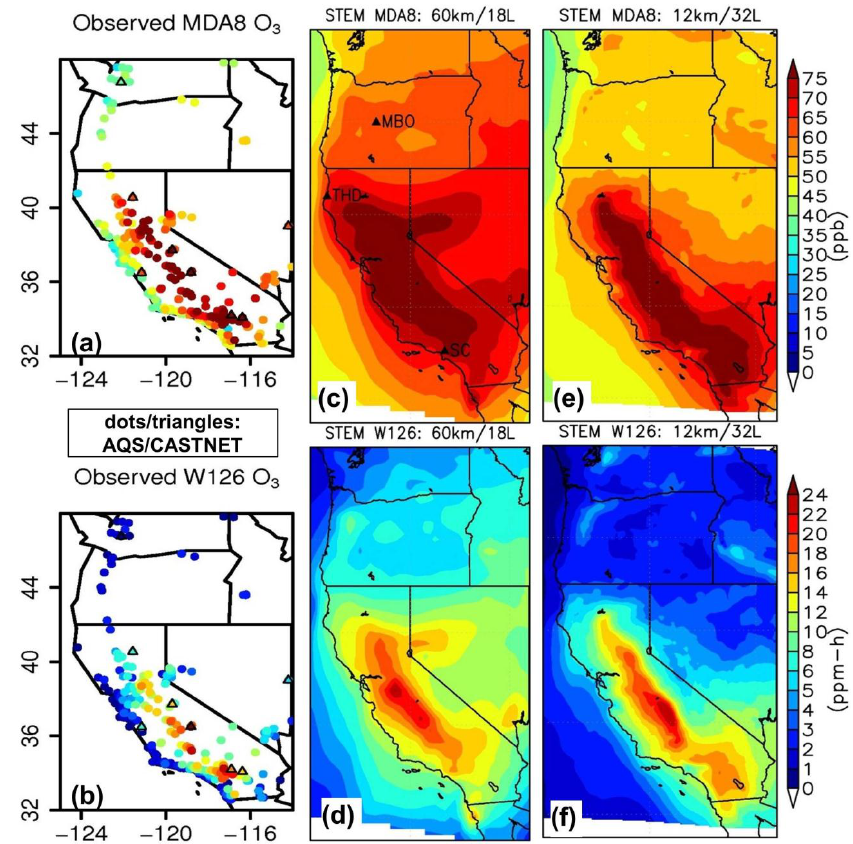
Fig. 2. Comparison of observed and modeled MDA8 and W126 monthly index (MI). See text in Sect. 3.1.1 for definition of MDA8 and W126 MI indexes. (a–b) Observed MDA8 and W126 MI at EPA AQS (dots) and CASTNET (triangles) sites; Modeled surface (c,e) MDA8 and (d,f) W126 MI in (c–d) 60km/18 layer and (e–f) 12km/32 layer